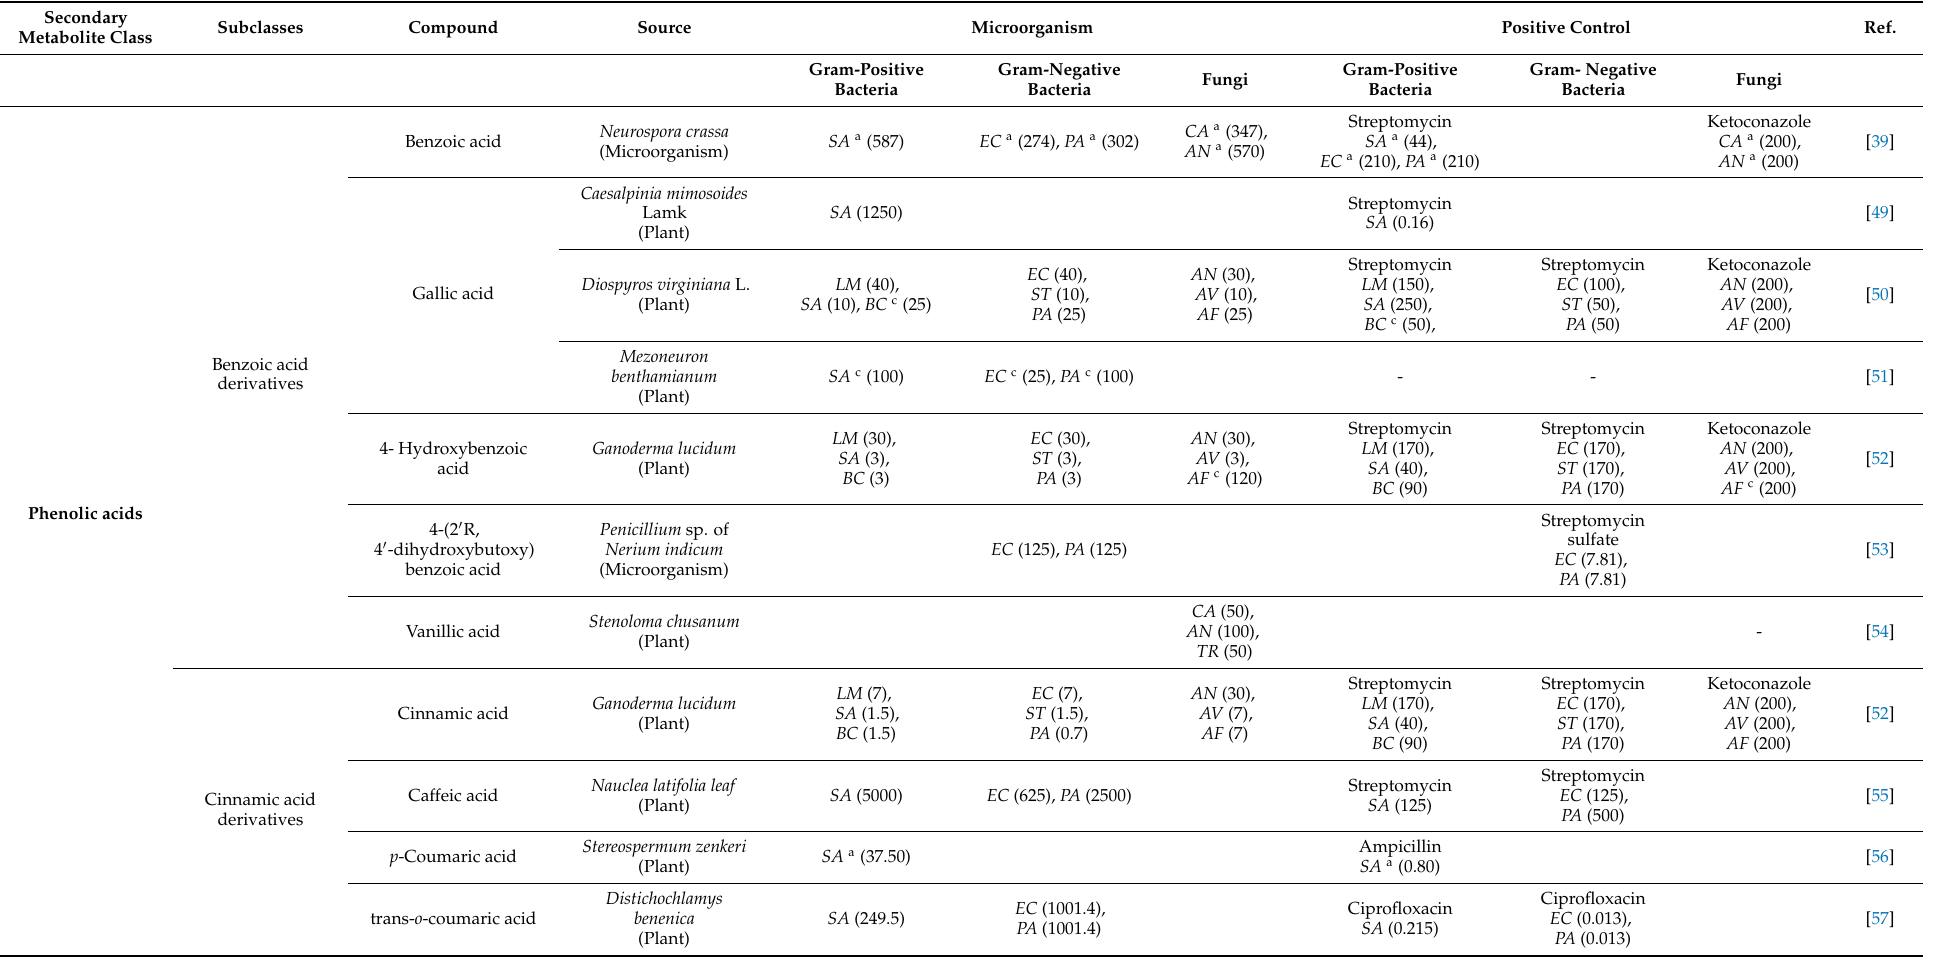
Table 1. Minimum inhibitory concentration ( µ g/mL) of phenolic and polyphenolic compounds against different pathogenic